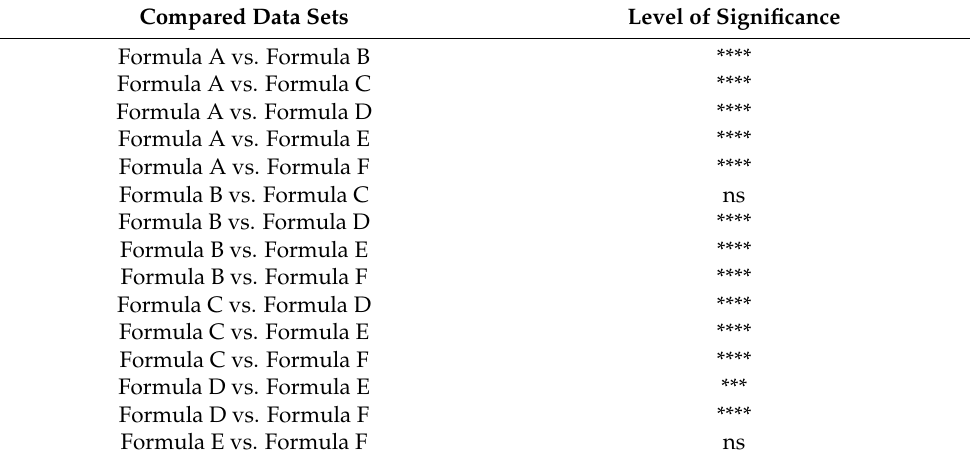
Table 6. Results of Tukey’s multiple comparison test generated by the data of methyl salicylate diffusion